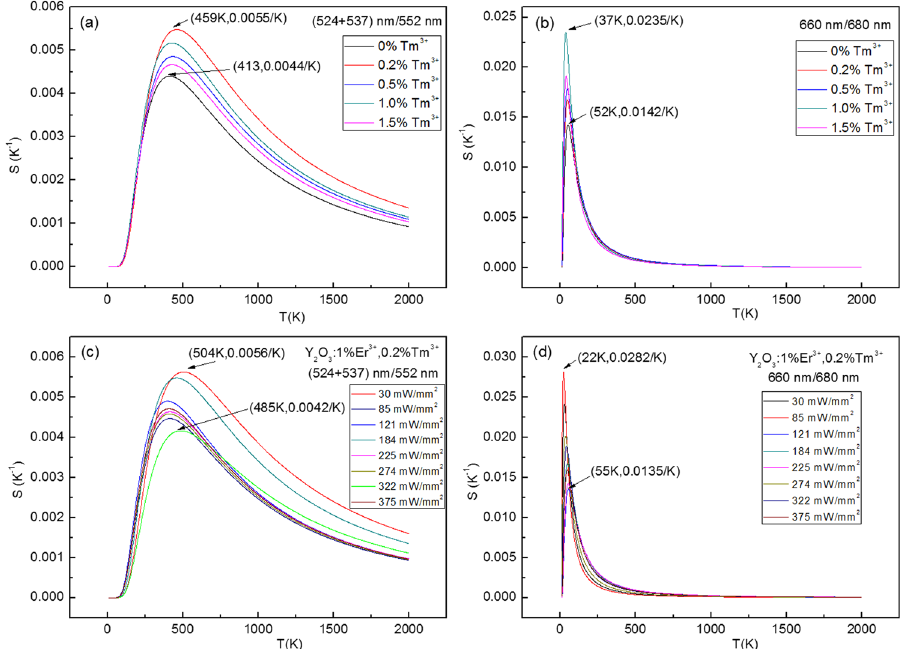
Figure 14. Doped concentration dependent sensitivity of Y 2 O 3 :1%Er 3 + , x%Tm 3 + (x = 0, 0.2, 0.5, 1.0, 1.5), and